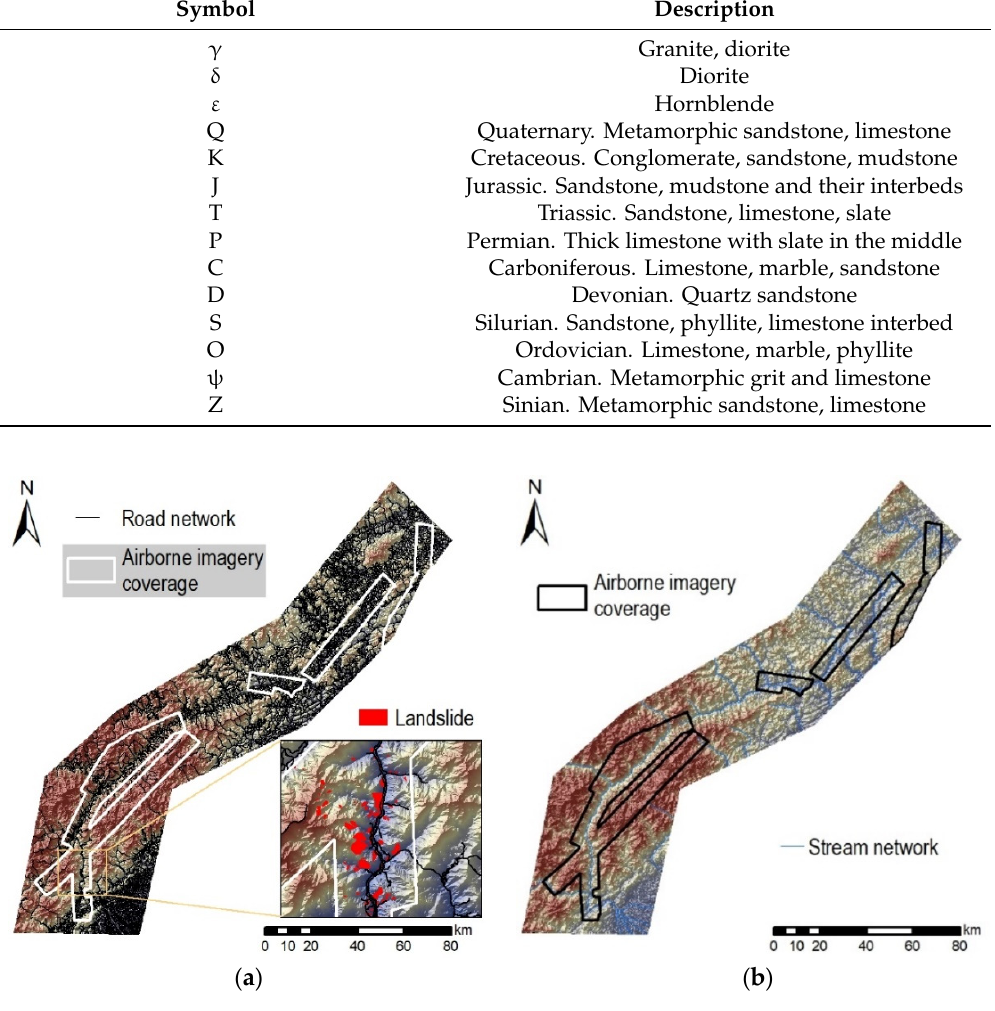
Figure 6. Human activity factors of post ‐ earthquake landslides. ( a ) Road network; ( b ) Stream network.